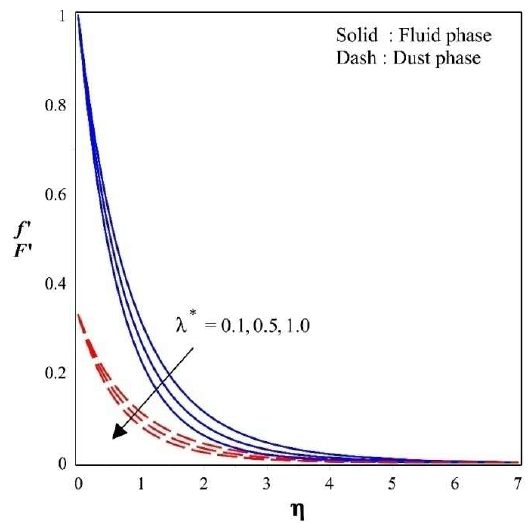
Figure 4. Effect of the porosity parameter on the fluid- and dust-phase velocity profiles.